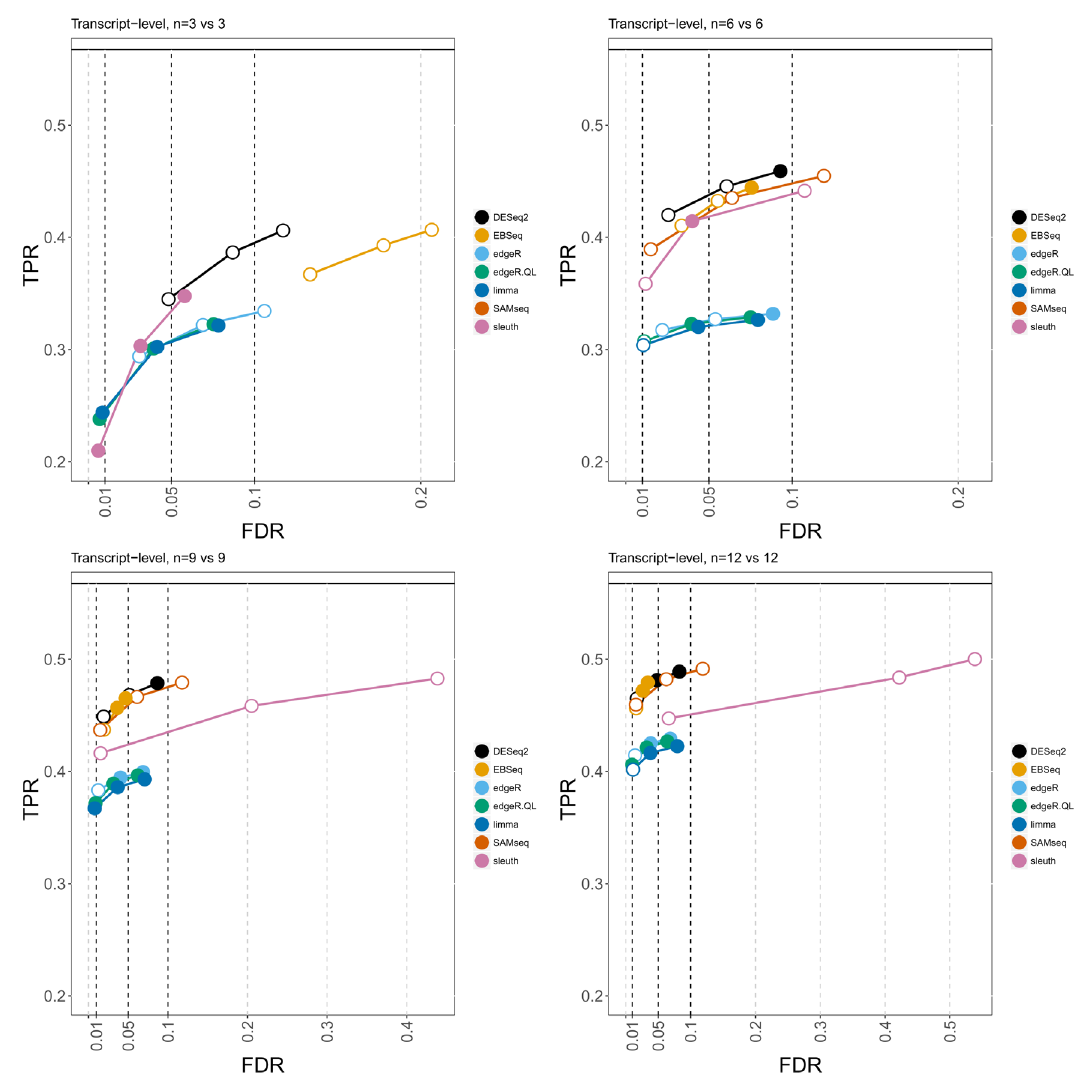
Figure 14. True positive rate over false discovery rate for differential transcript expression of the simulated dataset. The four panels are for per-group sample sizes: 3, 6, 9, and 12, as indicated in the title. The y-axis remains fixed but the x-axis changes scale in the bottom